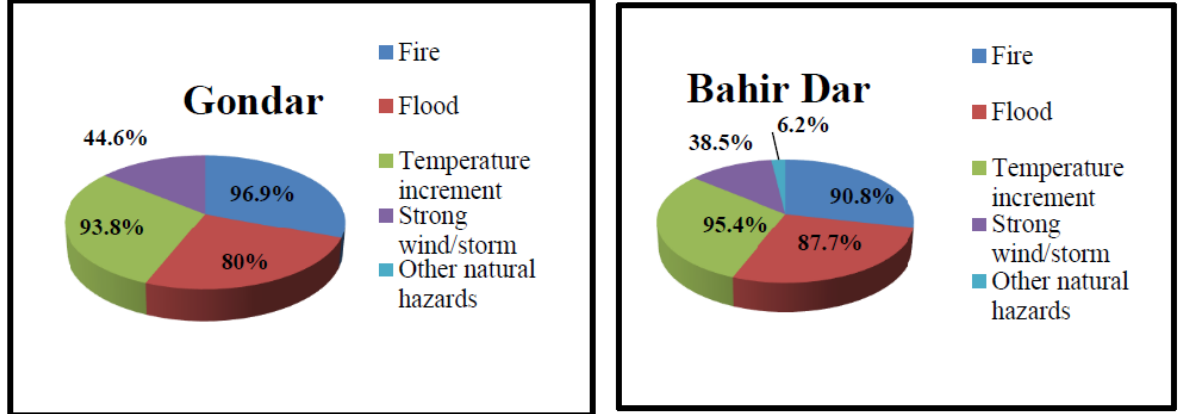
Figure 4. Hazards that occurred in the study areas (Source: Field survey, 2021).